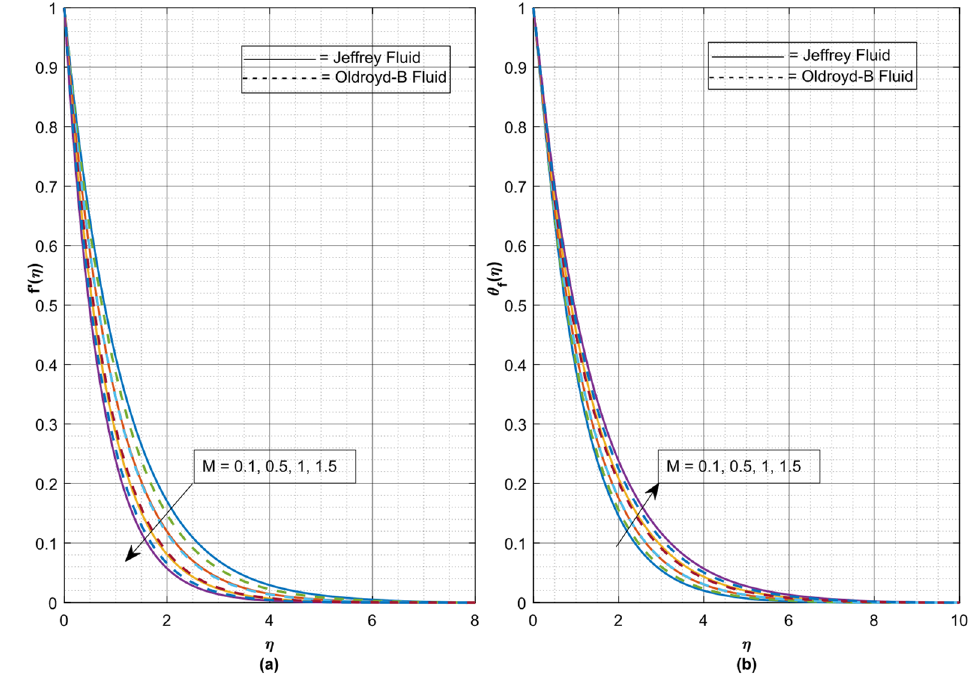
( ) ' f η and (b) Impact of M on